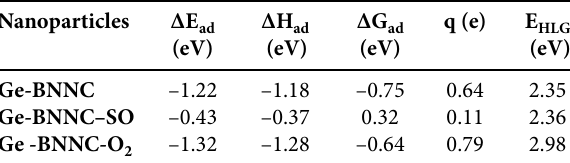
Table 1. Obtained parameters for Ge adoption of BNNC and calcu- lated parameters for SO and O 2 adsorption on Ge-BNNC surface.